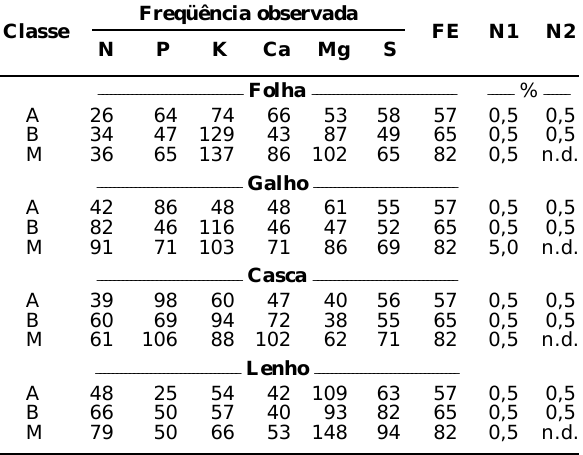
tese nula 2 (freqüência dos nutrientes como mais limitantes foi igual entre as subpopulações de média produtividade com as demais